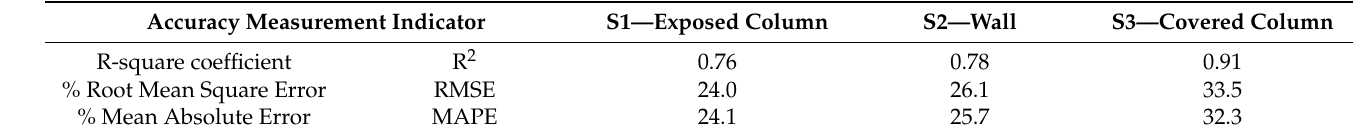
Table 4. Results of statistical evaluation error comparison between experimental data and simu- lated data.